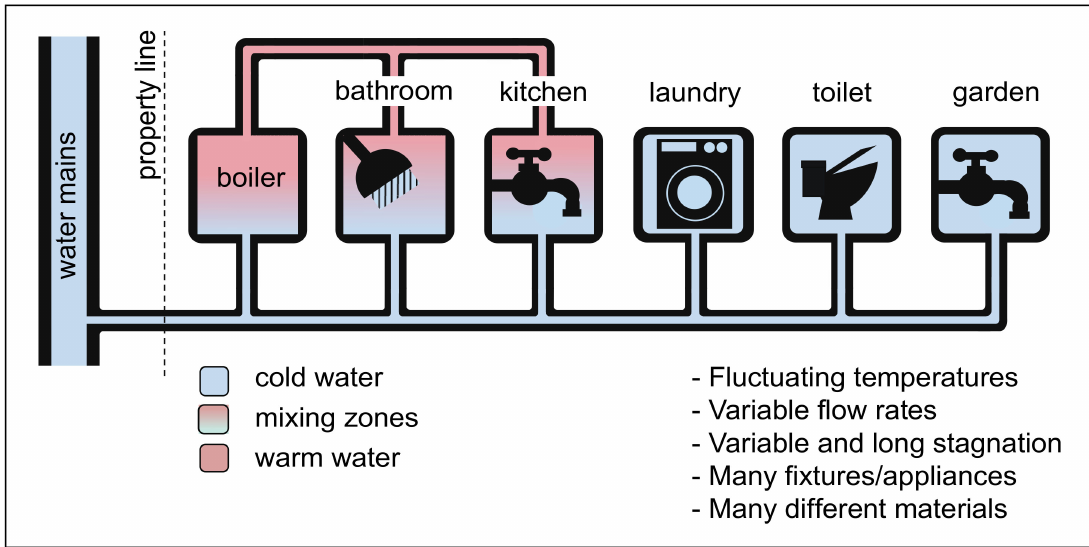
Figure 2. The complexity of building plumbing systems a ff ects environmental conditions and ultimately alters the drinking water microbial composition and